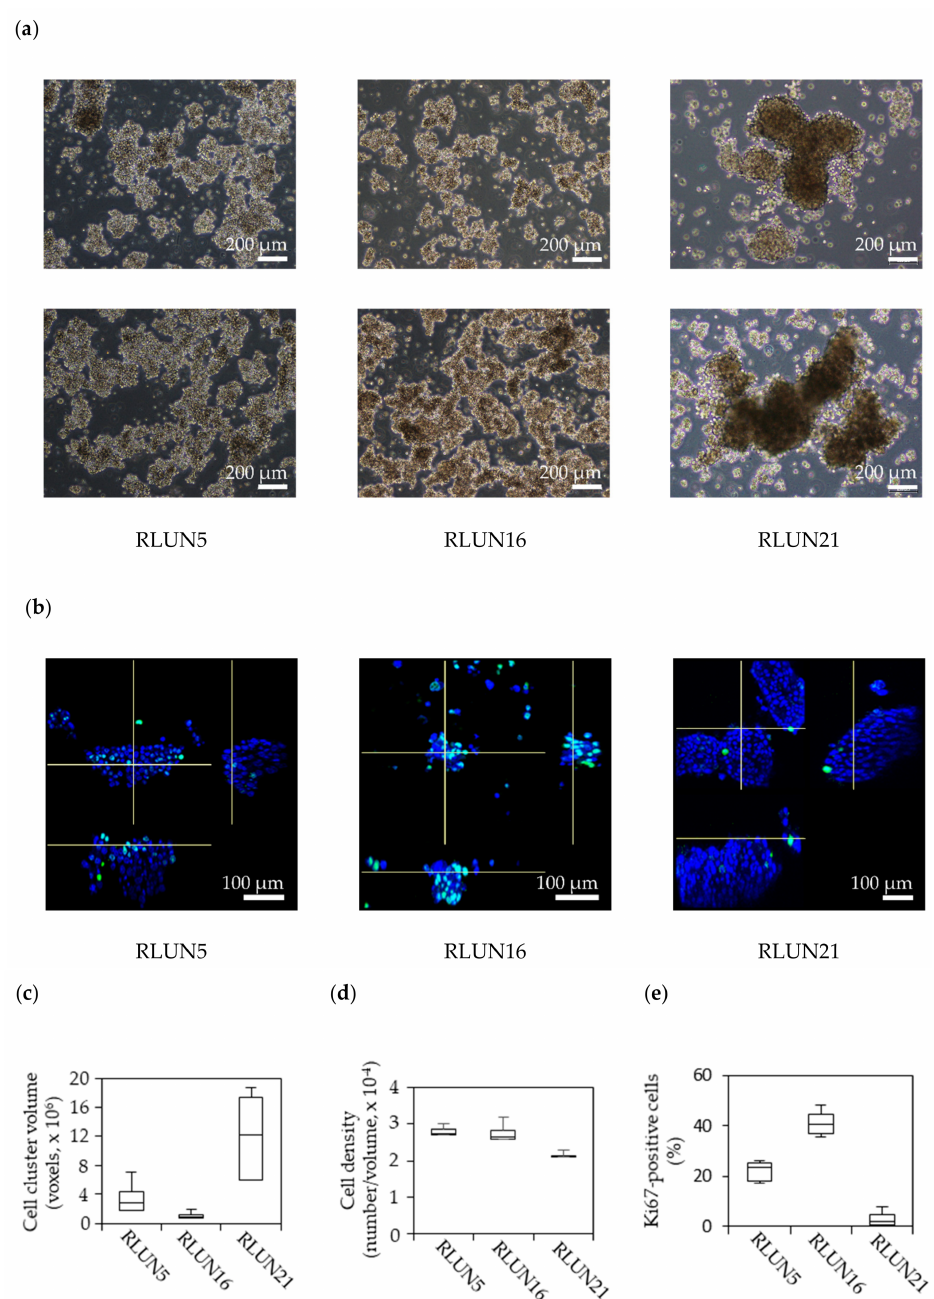
Figure 1. Phase-contrast and confocal images of three lung F-PDOs. ( a ) Phase-contrast images of RLUN5, RLUN16, and RLUN21 were obtained using a × 4 objective. Scale bar: 200 µ m. The upper panels show each F-PDO immediately after passage and the lower panels show each F-PDO before passage. ( b ) Confocal images of RLUN5, RLUN16, and RLUN21 were obtained using a × 10 objective. Scale bar: 100 µ m. Ki67-expression images for RLUN5, RLUN16, and RLUN21, prepared using an anti-Ki67 antibody (green). DNA stained with DAPI (blue). ( c – e ) Confocal imaging data analyzed with NoviSight. ( c ) Box-and-whisker plot of the cell cluster volumes. ( d ) Box-and-whisker plot of the cell density expressed as the cell number / cell volume in a cell cluster. ( e ) Box-and-whisker plot of the Ki67-positive ratio expressed as 100 × the number of positive cells / the number of total cells in a cluster. The cell number, cell volume, cell density, and Ki67-positive cell number in four representative cell clusters of each F-PDO were analyzed with NoviSight (Figure 1b–e). The total cell number